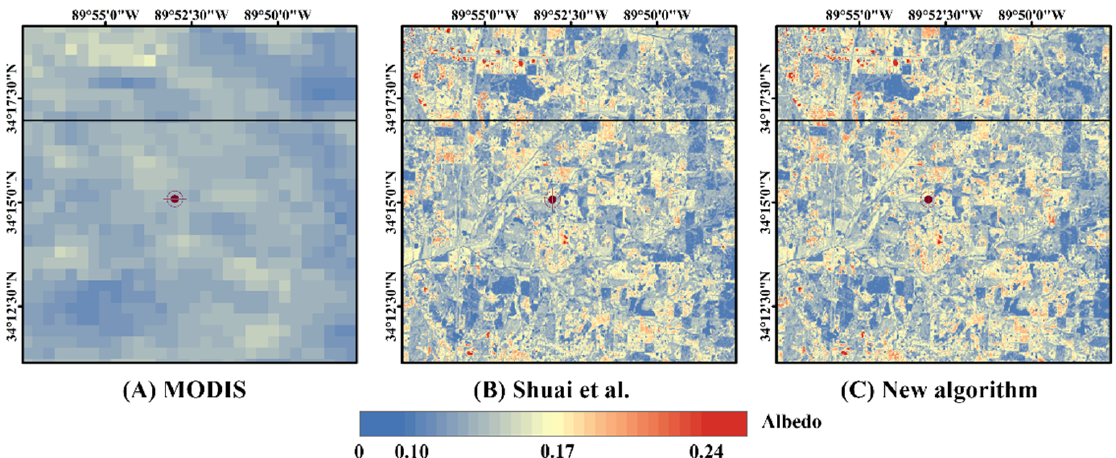
Figure 8. Black-sky albedo spatial distribution of 500-m MODIS at Landsat illumination ( A ), concurrent approach product ( B ), and new algorithm product ( C ) over a range of 15 × 15 km at GWN on April 9, 2014. A dark red sign indicates the location of the Goodwin Creek (GWN) site. Figure 9 shows the histograms of the three albedo products in Figure 8. Here, the standard deviation (Stdev) was used to quantify the magnitude of spatial heterogeneity between the MODIS product, CAP, and NP. Unsurprisingly, the standard deviations of both CAP and NP were significantly higher than that of MODIS albedo. The standard deviation of the MODIS product was 0.009, while that of CAP and NP were 0.026 and 0.027, respectively, indicating that the two finer albedo products had similar spatial heterogeneity.